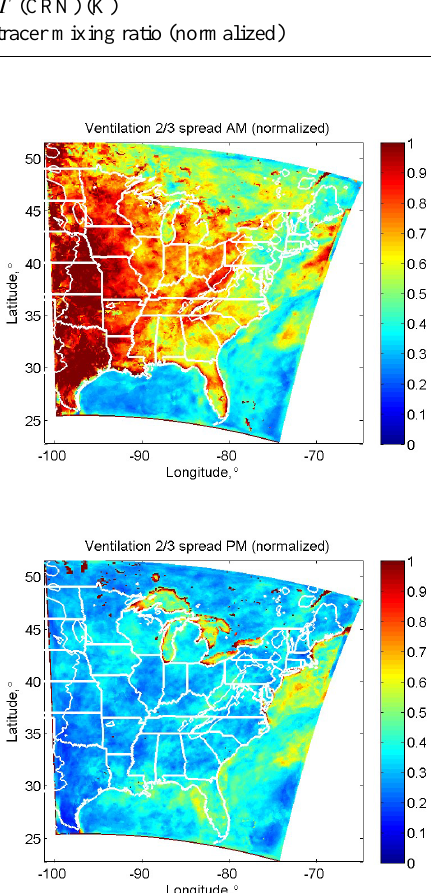
Figure 8: Spread of ventilation (PBL height * wind speed) in the early morning and midday. 558 Figure 8. Spread of ventilation (PBL height · wind speed) in the Spread is normalized by the mean value. 559 early morning and midday. Spread is normalized by the mean value.